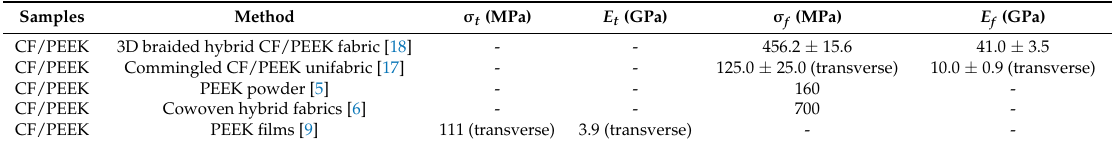
Table 3. Longitudinal and transverse tensile properties of CF/PEEK unidirectional plates at different isothermal temperatures. ( σ t is the tensile strength; E t is the tensile modulus; σ f is the tensile strength; E f is the tensile